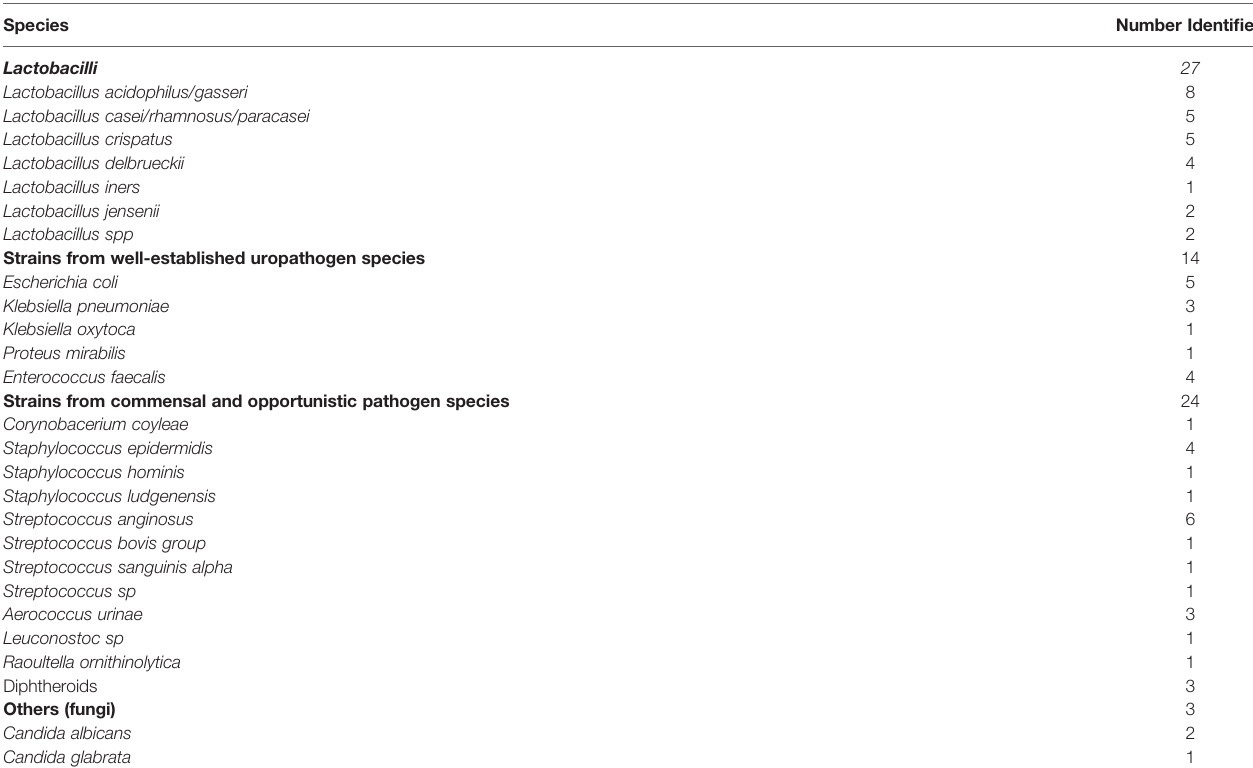
TABLE 1 | Urinary Isolates